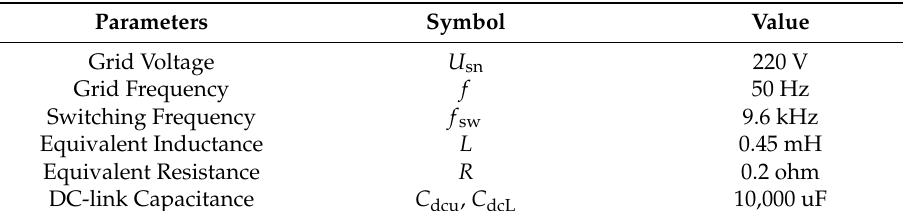
Table 2. Parameters of APF prototype and experimental setup.